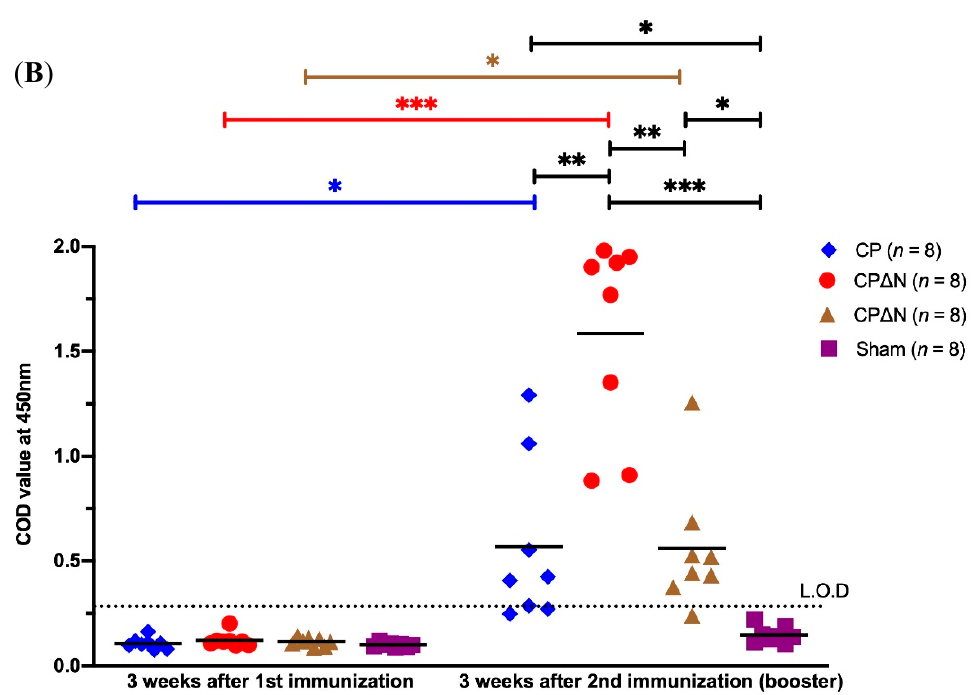
Figure 2. Schema of mice immunization study and indirect enzyme-linked immunosorbent assay (ELISA) titers of sera collected three weeks after the first and second immunization. ( A ) The MAstV vaccine candidates (5 µ g / mouse) combined with an equal volume of AbISCO-100 adjuvant (10 µ g / mouse) were injected subcutaneously to Naval Medical Research Institute (NMRI) mice ( n = 8 per group, 4 weeks old) twice with a three-week interval. Mice injected with pDual-GC-vector-transfected cell lysate (5 µ g / mouse) combined with adjuvant (10 µ g / mouse) were analyzed as a sham group ( n = 8). Spleen samples were collected at the end of the trial for ex vivo proliferation and cytokine analysis. ( B ) The serum samples of mice were collected three weeks after each immunization and tested with an indirect ELISA (Limit of detection (L.O.D) is the corrected optical density (COD) above 0.3). CP refers to the full-length capsid protein (spanning amino acids (aa) 1–775 of CP) of MAstV; CP ∆ N refers to an N-terminal truncated protein (spanning aa 161–775 of CP) of MAstV; CP ∆ C refers to a C-terminal truncated protein (spanning aa 1–621 of CP) of MAstV; Sham refers to the control group injected with pDual-GC-vector-transfected cell lysate. The mean value of each group ( n = 8) of mice was calculated, the COD value of each mouse is illustrated in the dot plot. Asterisks indicate the level of significant di ff erence between the mean value of either immunized or sham groups using two-way analysis of variance (ANOVA) with replication test (* p < 0.05, ** p < 0.01 and *** p < 0.001). Bars represent the mean value for each group.